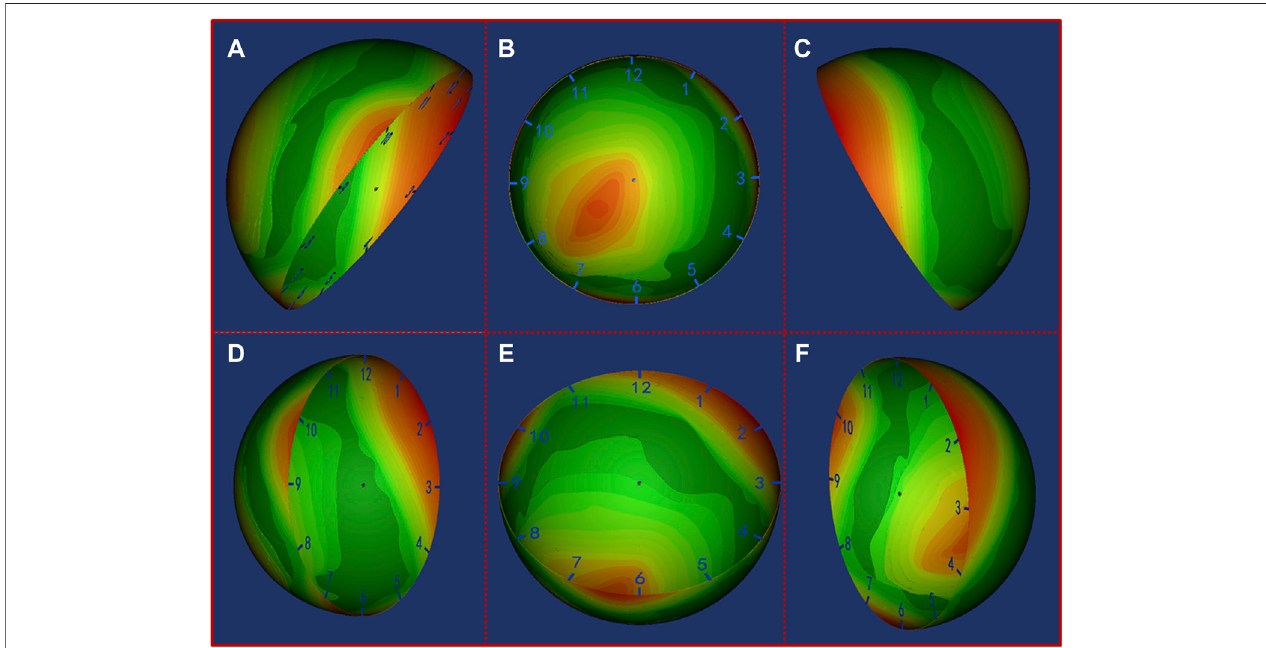
FIGURE6| DistributionmapoftheuncoveredareainAAOSIIIgroup.Greentoredindicatesthattheuncoveredfrequencyrangesfromlowtohigh. (A) Frontviewof thepelvis, (B) openingorientationviewofthecup, (C) Backviewofthepelvis, (D) Lateralviewofthecupfromfronttoback, (E) Lateralviewofthecupfrombottomtotop, (F) Lateral view of the cup from back to front.